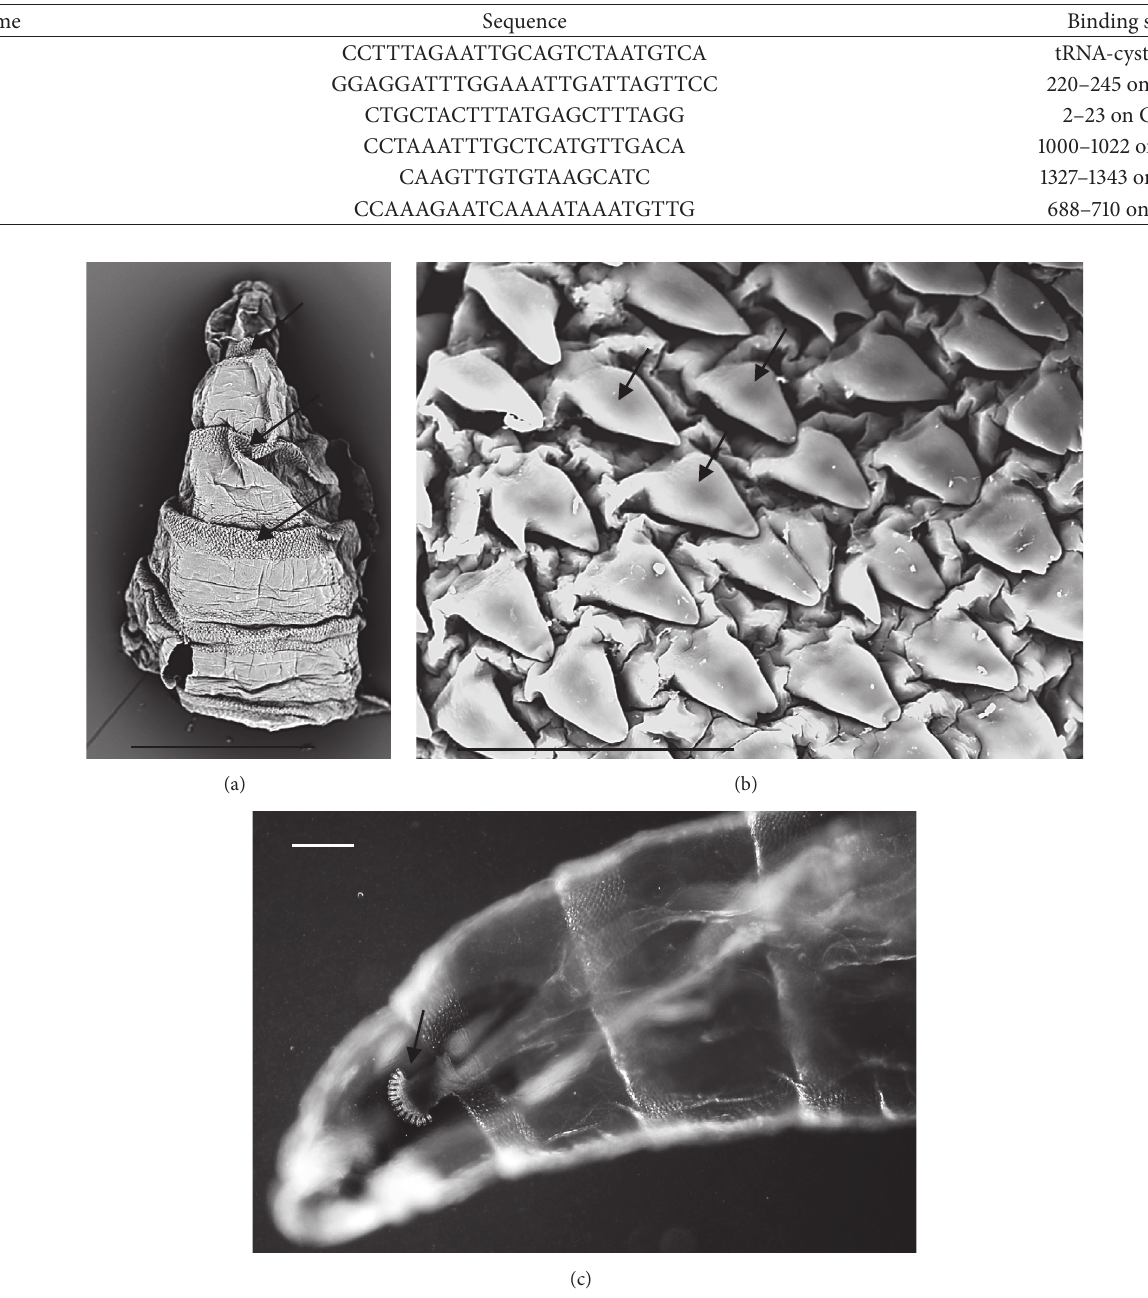
Figure 1: Sarcophaga sp. third instar larva. (a) SEM image, anterior dorsal view of the body showing the interband areas free of any spines/warts and the anterior spinose band (arrows). (b) SEM image, detail of the spines on the anterior spinose band areas (arrows). (c) LM image, lateral view of anterior body showing anterior spiracle with 14-digit-like lobes clearly visible . Scale bar: 1mm (a); 50 𝜇 m (b); 100 𝜇 m